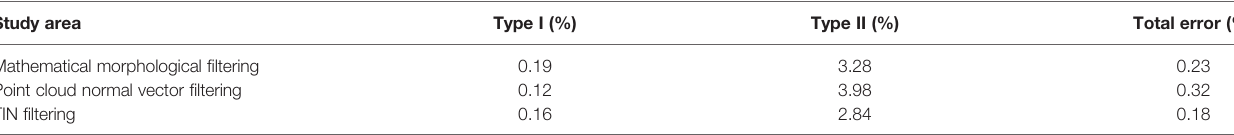
TABLE 3 | Accuracy analysis of fi ltering